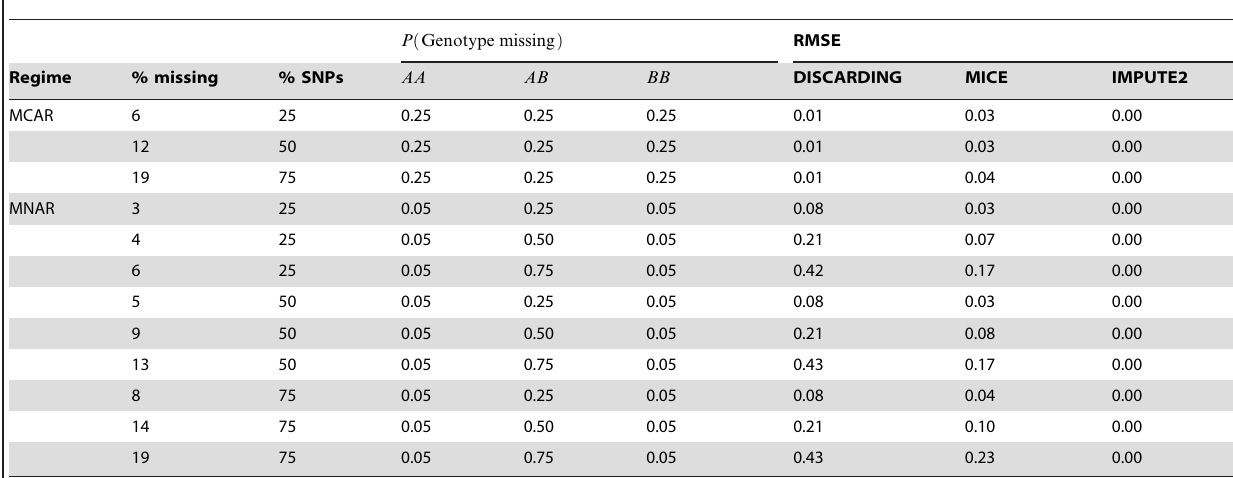
Table 4. Simulation